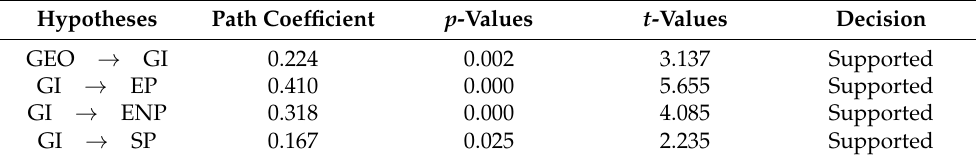
Table 4. Hypotheses Testing Results.